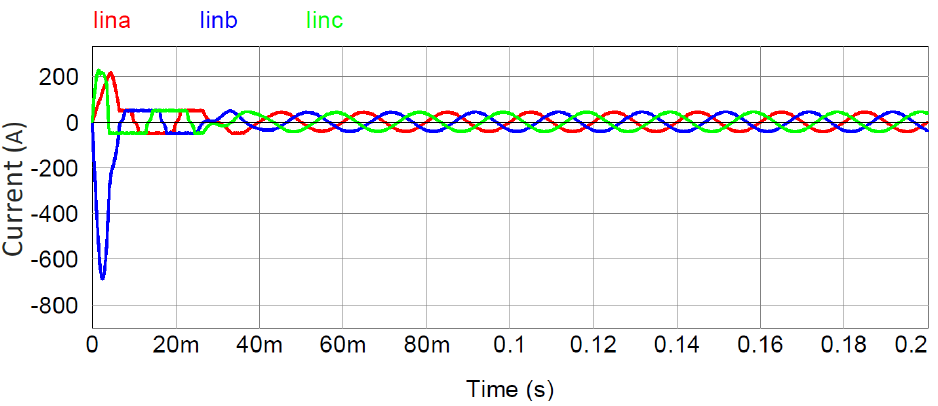
Figure 17. Analysis of the starting period of the rectifier in the three phases.